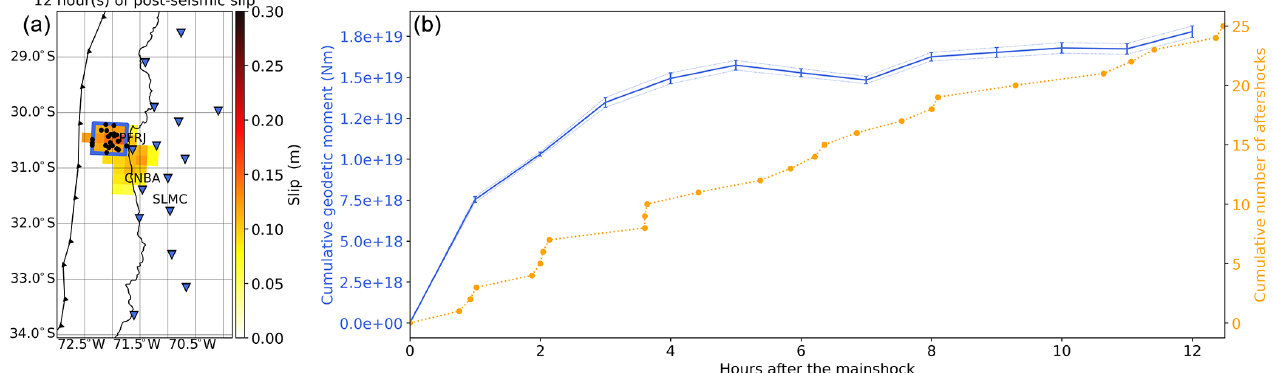
Figure 8. (a) Post-seismic slip distribution after 12h and obtained using the position time series with the two largest aftershocks removed. We show with the blue square the identified northern patch that is slipping almost purely aseismically. The black dots show the aftershocks inside this region from the catalog of Huang et al. (2017). See Fig. 1 for details on the symbols. (b) Time evolution of the cumulative geodetic moment of afterslip (blue line) along with the time evolution of the cumulative number of aftershocks (orange dotted line). All curves are obtained from the inside of the blue rectangle shown on (a)